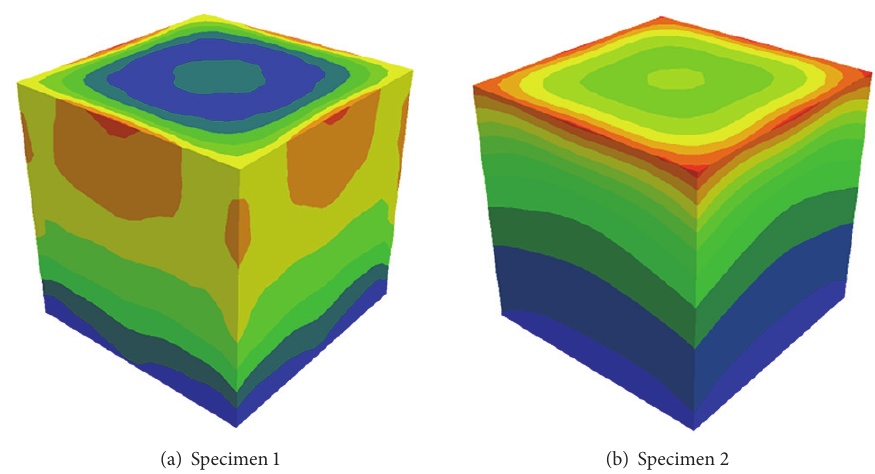
Figure 2: Contour of shear stain increment.